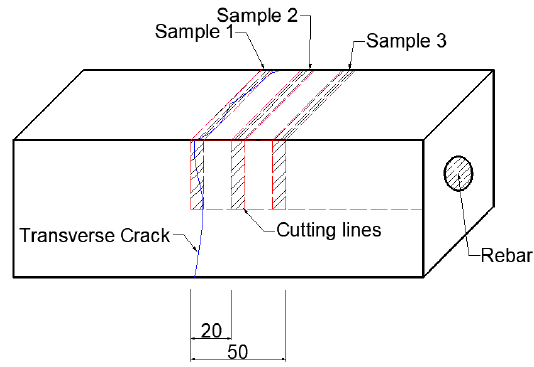
Figure 2. Sampling areas used for the chemical titration of chloride ions (mm).